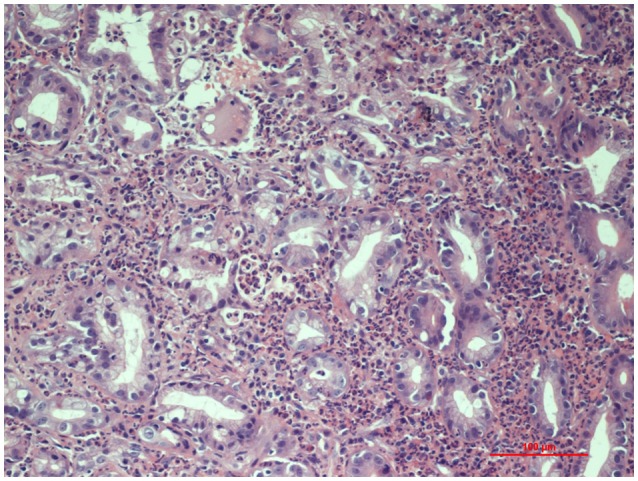
Histopathology of gastric mucosa showing active inflammation (Hematoxylin and Eosin staining, 20x magnification).